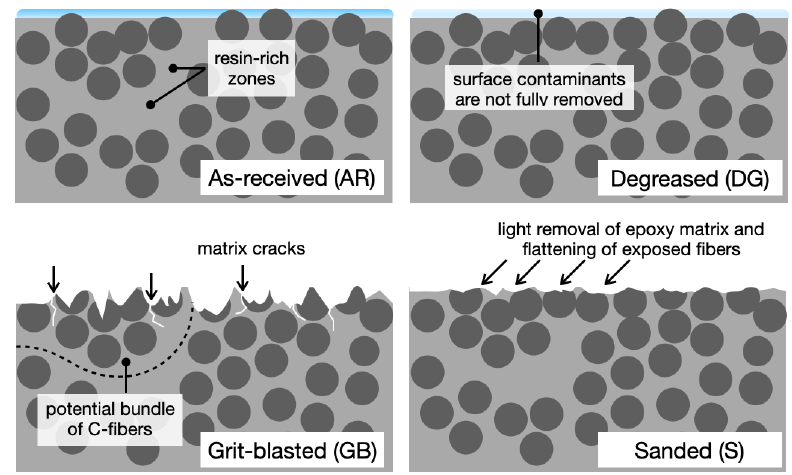
Figure 15. Schematic of the CFRP before and after different surface preparation